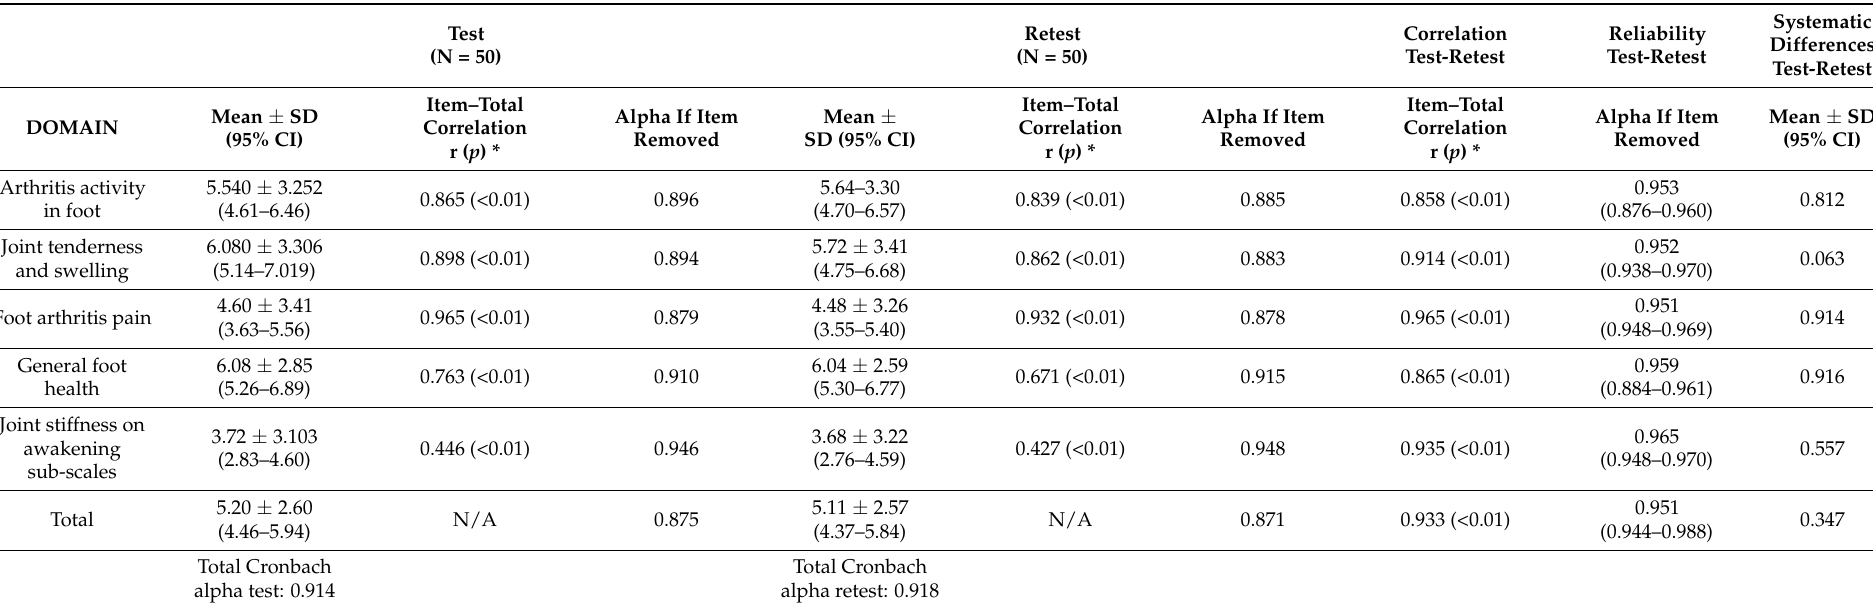
Table 2. Results of test-retest reliability, Item–total correlation and systematic differences of the RADAI-F5 according to each